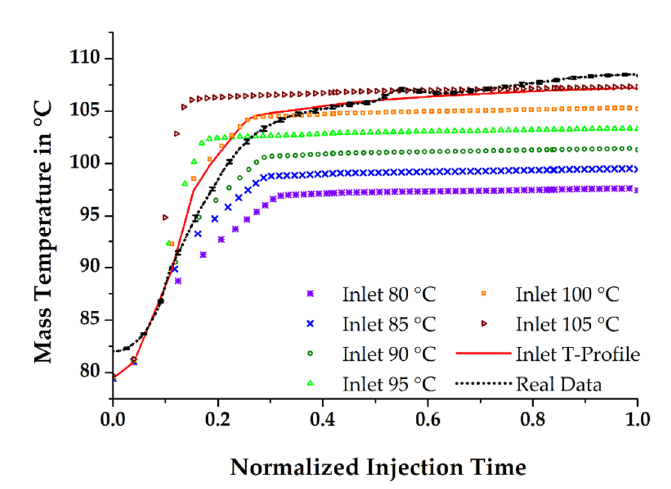
Figure 7. Mass temperature obtained at the surface area of the pT-sensor after various definitions of the compound’s inlet temperature and opposed to the measured curve from the injection molding process.